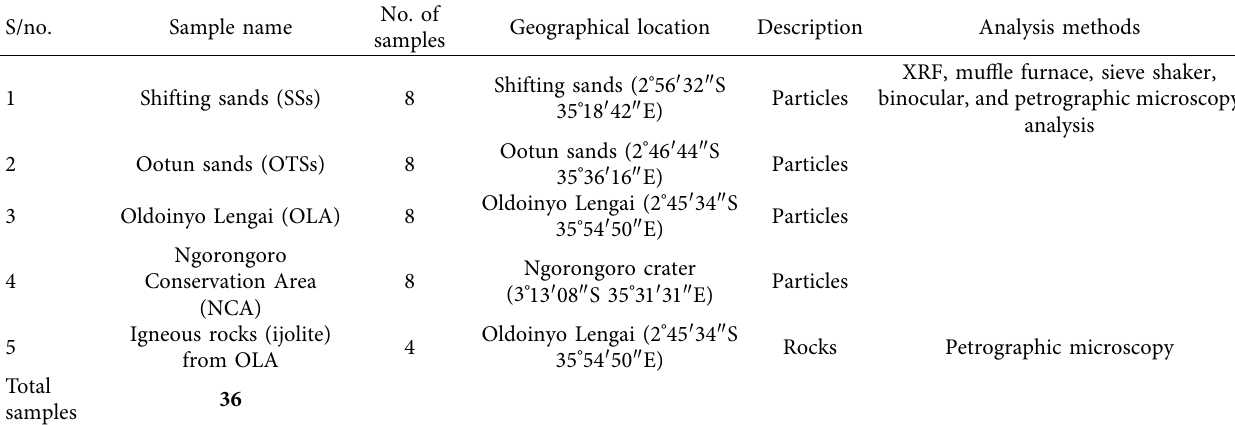
Table 1: Description of samples collected in the study.